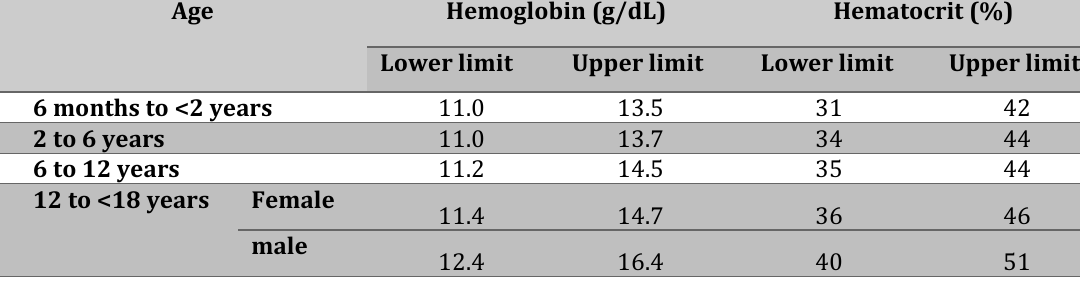
Table 1. Normal values for hematologic parameters in